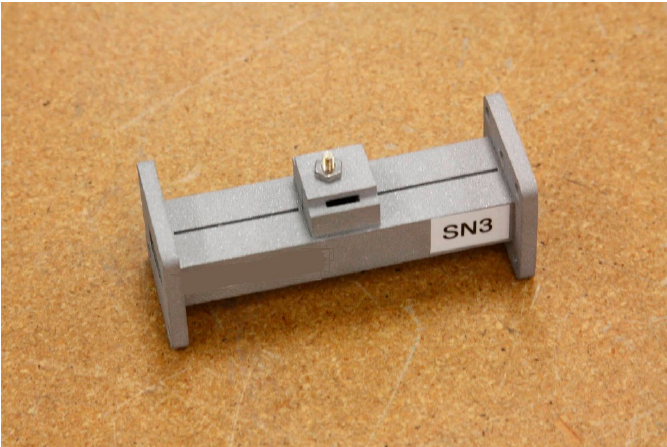
Figure 6. DMLS metal 3D printed single cavity notch filter.